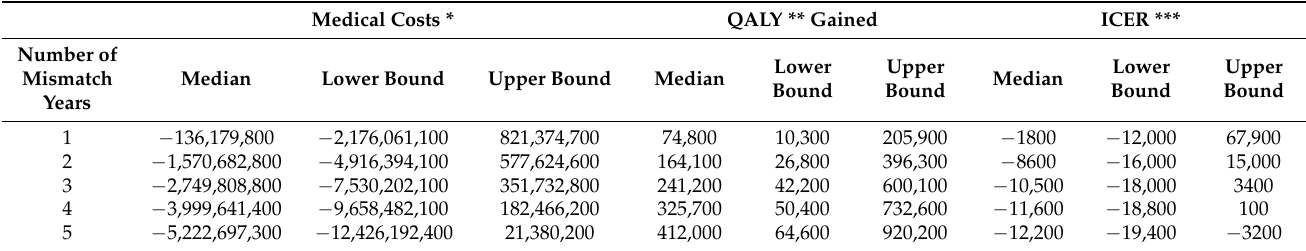
Table 3. Base case result—3 years of mismatch out of 5 years. The 3 years of mismatch considered are the 3 most recent influenza seasons.